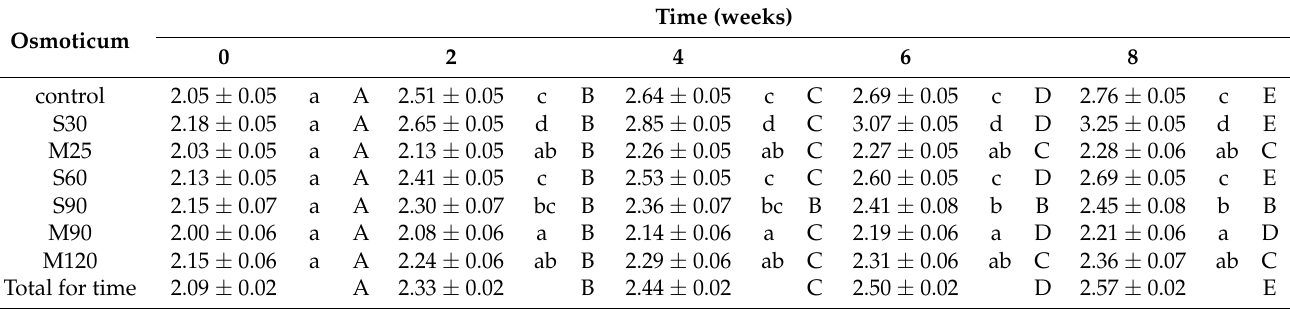
of mannitol. Effect of Osmoticum ×